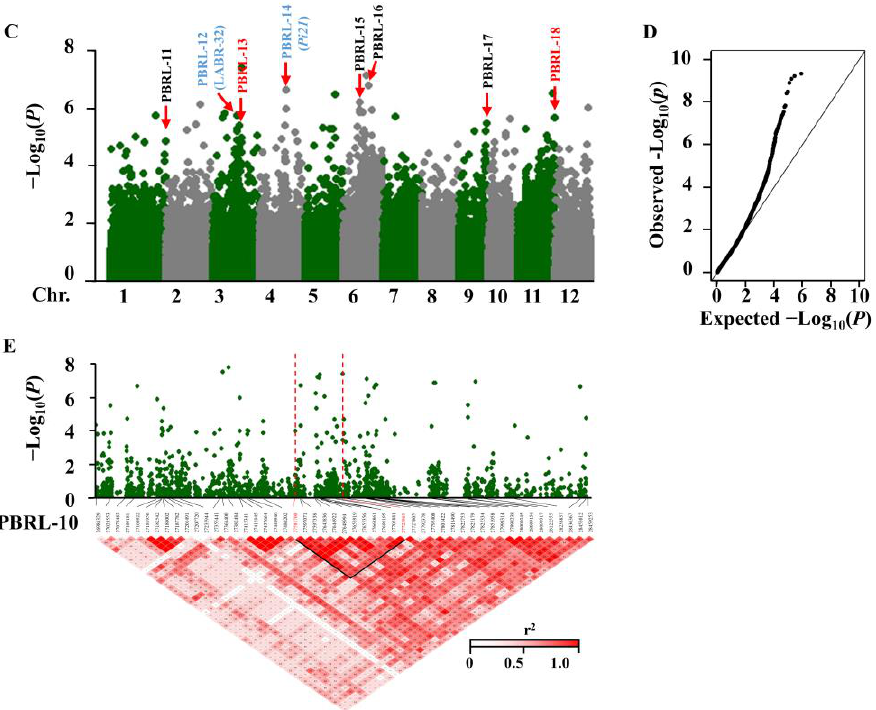
Figure 2. Genome-wide association study of panicle blast resistance. ( A , C ) Manhattan plots of markers associated with rice blast resistance to panicle blast; the X-axis is the location of each single nucleotide polymorphism (SNP) on the 12 chromosomes, and the Y-axis is the p value obtained from the GWAS model − Log 10 P . SNPs with strong associations with PBRLs had higher Y-coordinate values. The reported genes or loci are marked in blue font; the PBRLs identified by two-year data repeats are marked in red font; newly identified non-repeated PBRLs are marked in black font. ( B , D ) Quantile-quantile (Q-Q) plots showing the fitness of selected models for different traits across populations or subgroups. X-axis: expected − Log 10 P ; Y-axis: observed − Log 10 P . ( E ) Local Manhattan plot (top) (27.0–28.5 Mb) and LD heatmap (bottom) (27.0–28.5 Mb) around the peak of PBRL-10. Table 1. The PBRLs that were associated with panicle blast in 2018 and 2019.